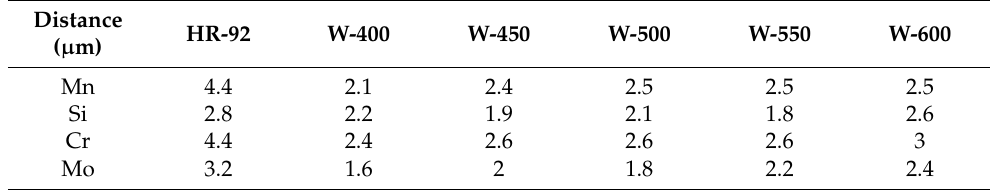
Table 2. Interfacial element diffusion distances of 18Mn/40Si2CrMo multilayer composite steel with different warm rolling temperatures.